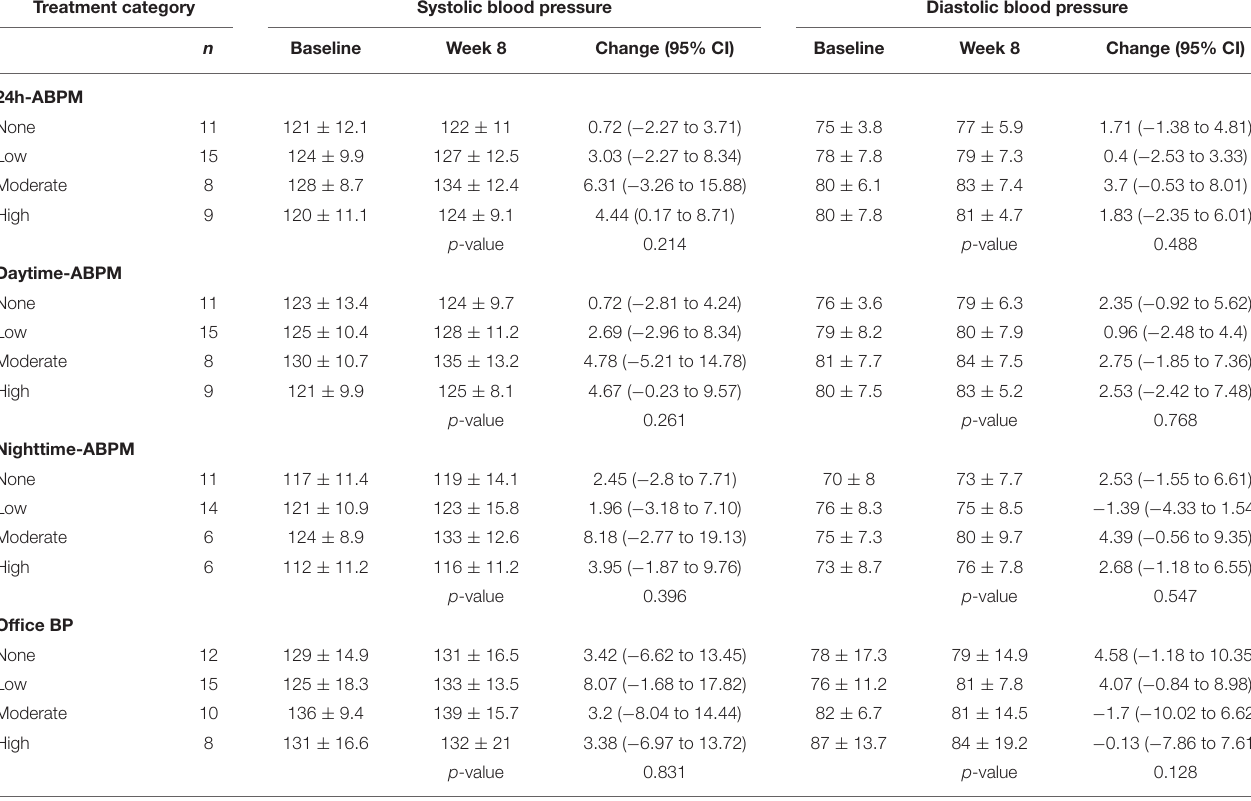
TABLE 2B | Mean office and 24h-ambulatory blood pressure measurements ( ± SD, mmHg) with respect to treatment categories and point in time and mean blood pressure change (95%CI, mmHg). Treatment category Systolic blood pressure Diastolic blood